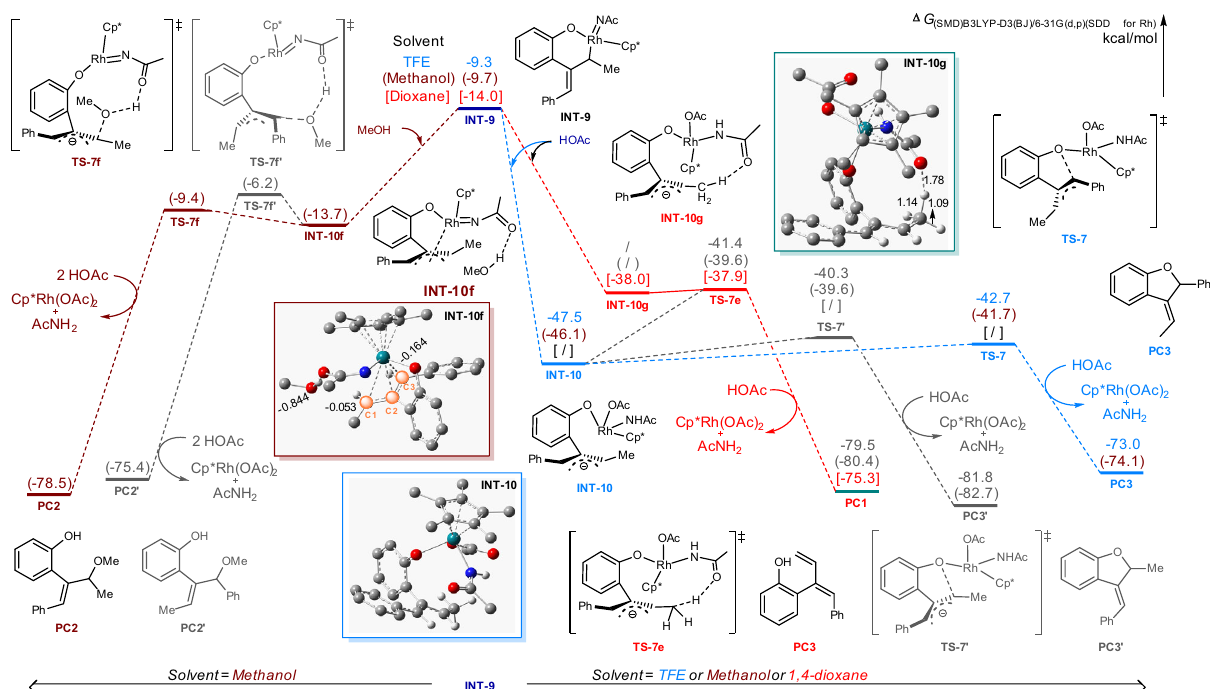
Fig. 9 Computed Gibbs free energy changes for the divergent assembly of diene, allyl ether, and dihydrobenzofuran derivatives from INT-5 tuned by the reaction solvent. The corresponding free energy pro fi les of different solvents were presented as follows: blue values for TFE, brown values in the parentheses for methanol and red values in the square brackets for